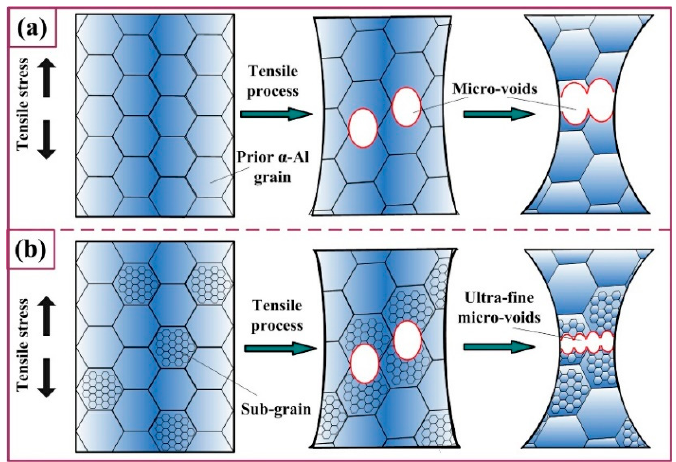
Figure 14. The schematic diagram of crack growth in different states: ( a ) T6, ( b ) S + EA.